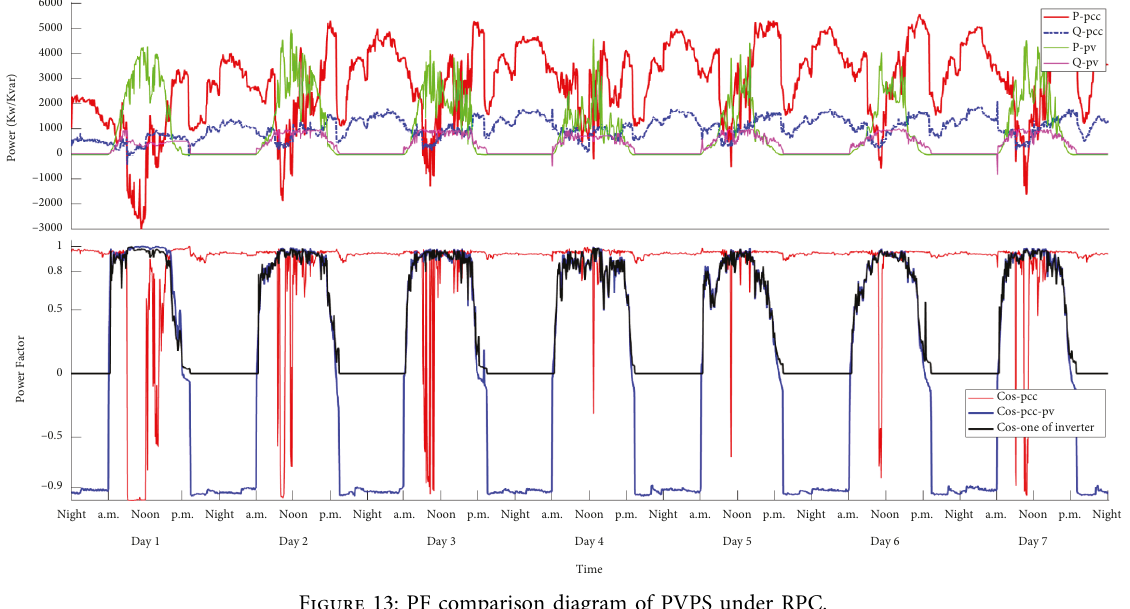
Figure 13: PF comparison diagram of PVPS under